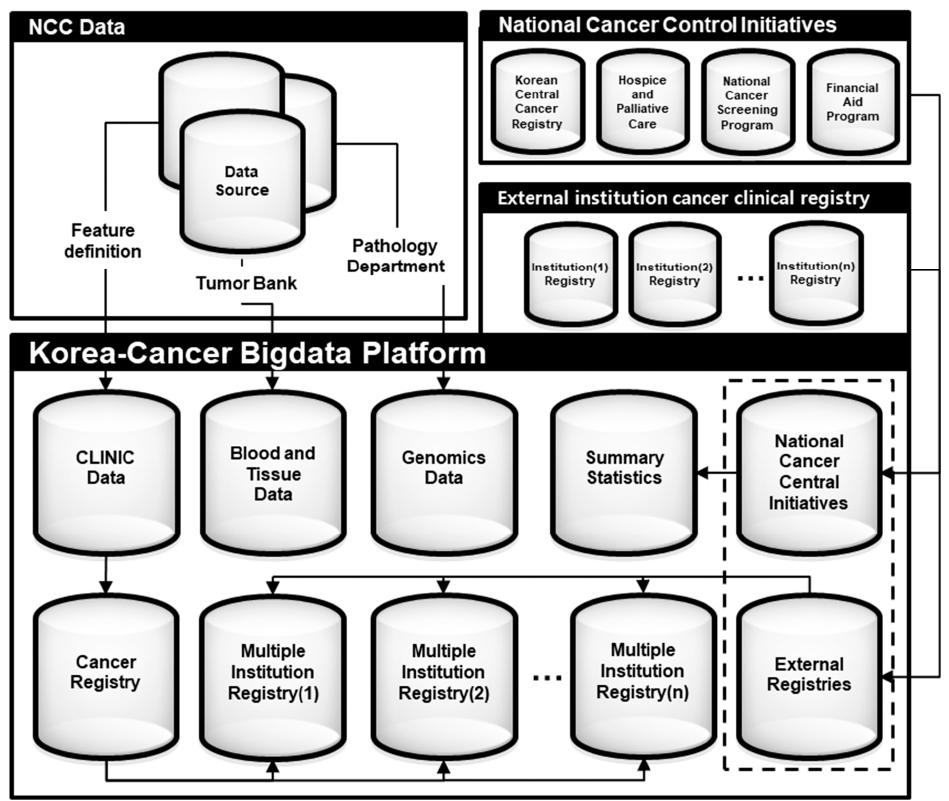
Figure 4. Dataset configuration of the Korea Cancer Big Data Platform (K-CBP). NCC, National Cancer Center.